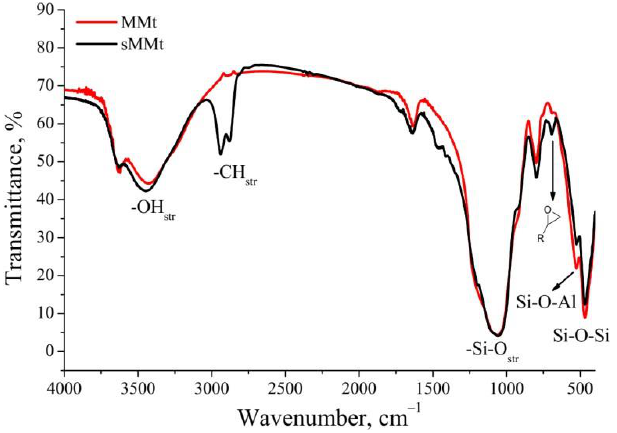
Fig. 1 FTIR spectra of MMt and sMMt